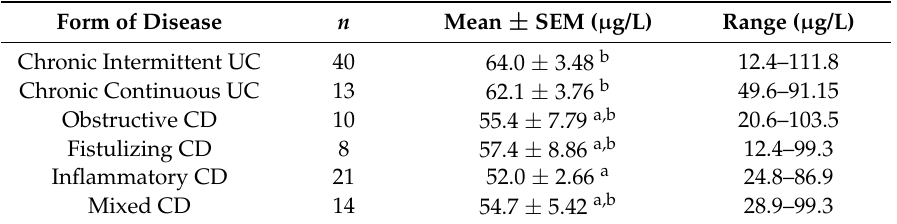
Table 7. Serum Se concentrations in IBD patients as a function of the form of the